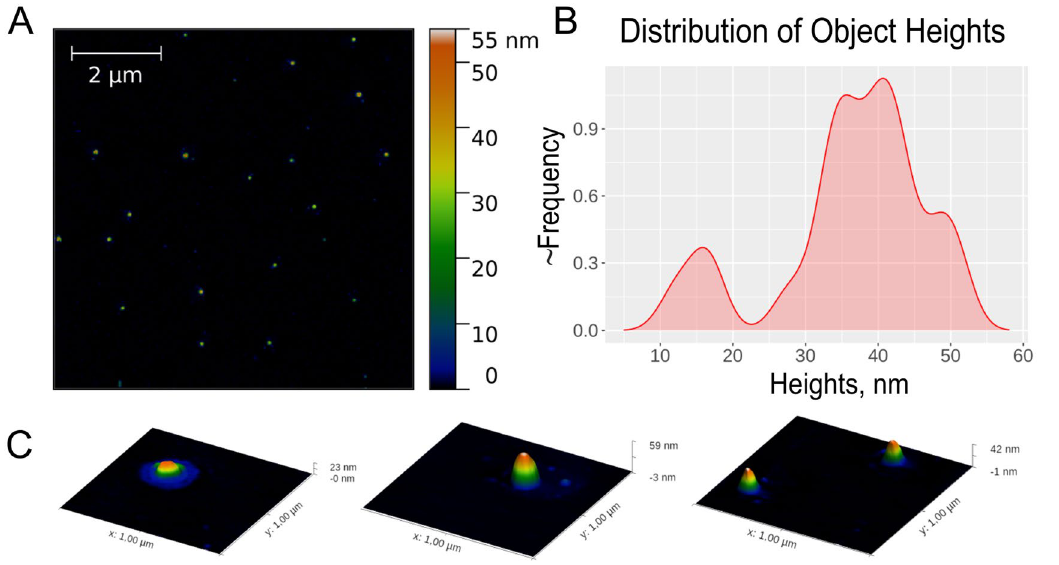
Figure 2. Characterization of grapefruit-derived nanoparticle size and morphology by Atomic Force Microscopy (AFM). ( A ) AFM images of grapefruit nanovesicles. ( B ) Height distribution of GF-EVs. ( C) 3D images of some representative individual vesicles.